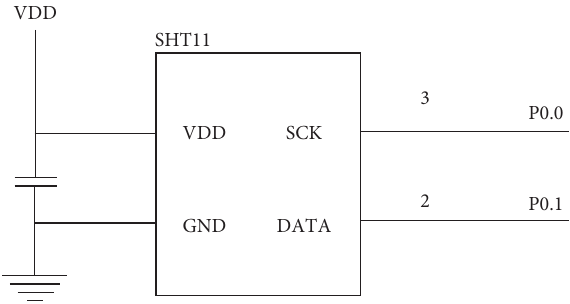
Figure 2: Temperature and humidity sensor module.